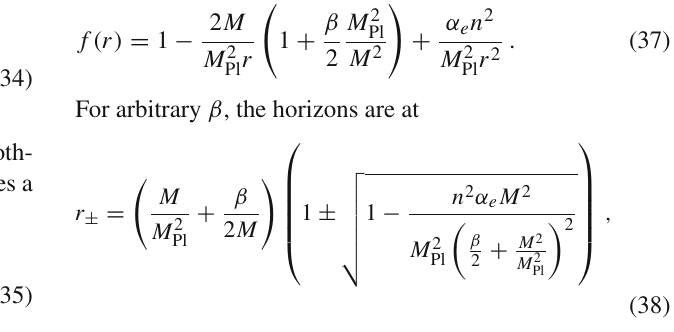
If n = 1, this condition